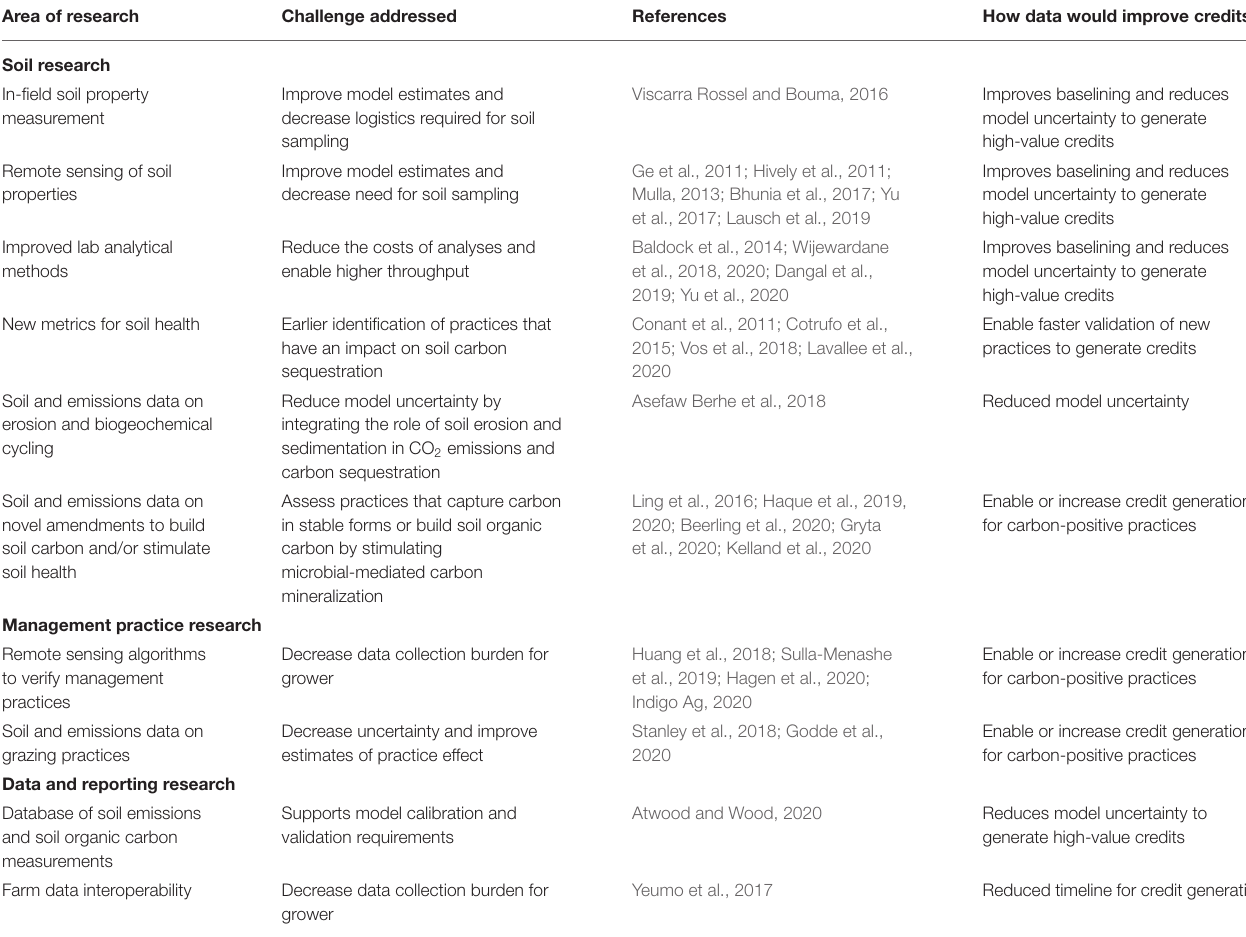
TABLE 2 | Landscape of research and technologies that could accelerate the impact of agriculture as a tool to reduce net GHG